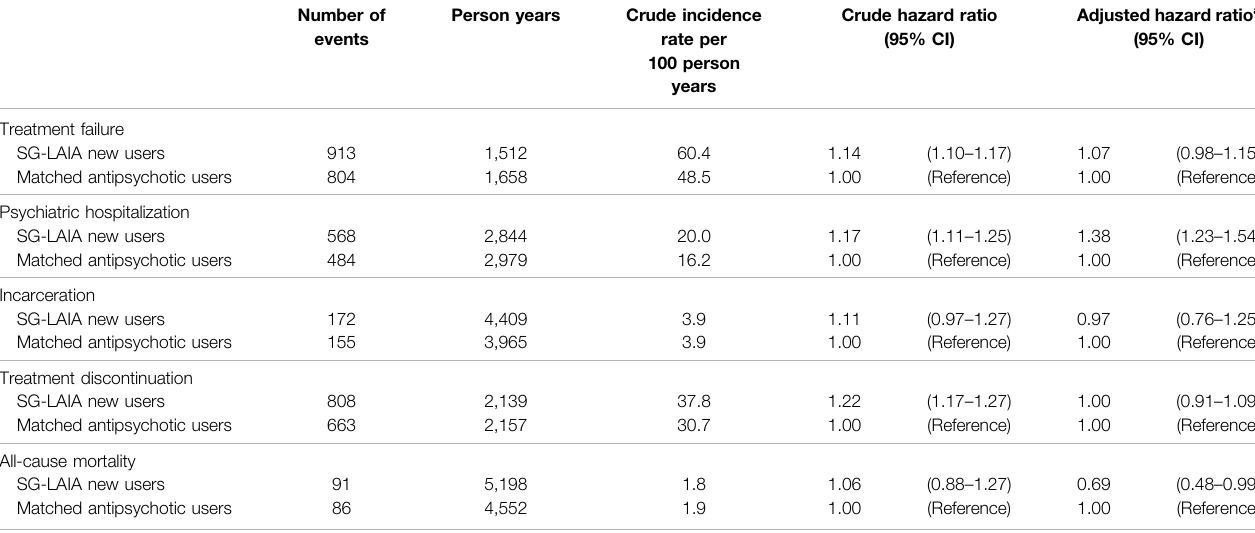
TABLE 2 | Association between second-generation long-acting injectable antipsychotics versus oral antipsychotics and treatment failure, psychiatric hospitalization, incarceration, treatment discontinuation and all-cause mortality.